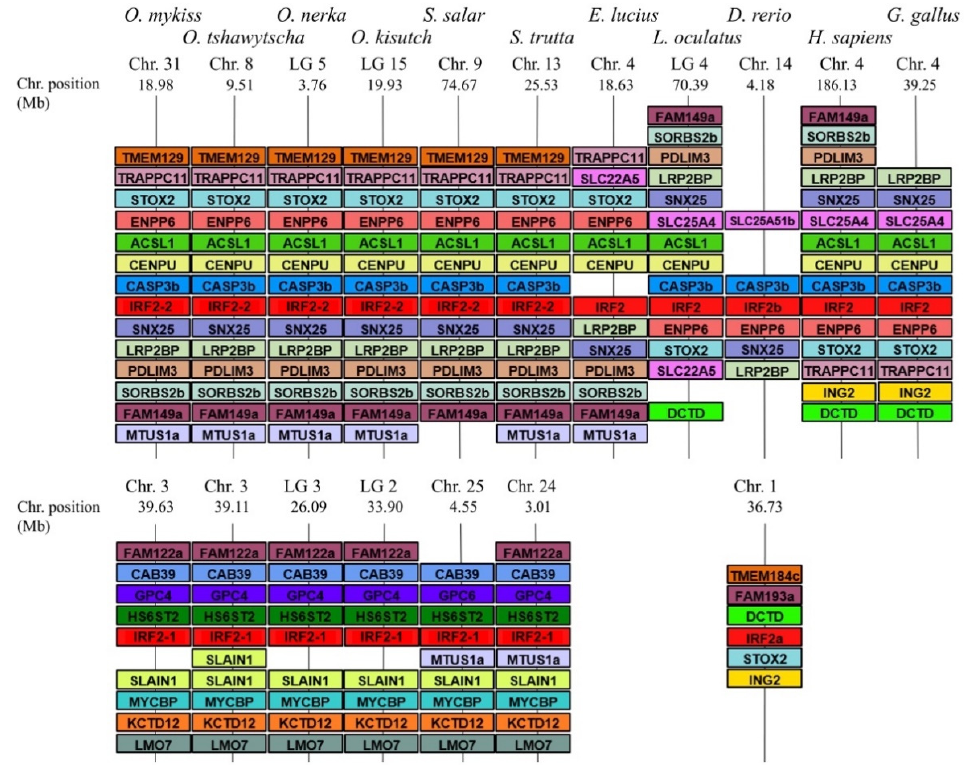
Figure 2. IRF2 gene synteny in salmonids. The syntenically conserved gene blocks are shown in matching colours. Gene synteny was compiled from up- and down-stream locations relative to each species IRF2 taken from NCBI’s genome browser. Species names are displayed at the top of the figure, IRF gene accession numbers are on Table S1, chromosome number and range (position) are shown above and below each species gene synteny.